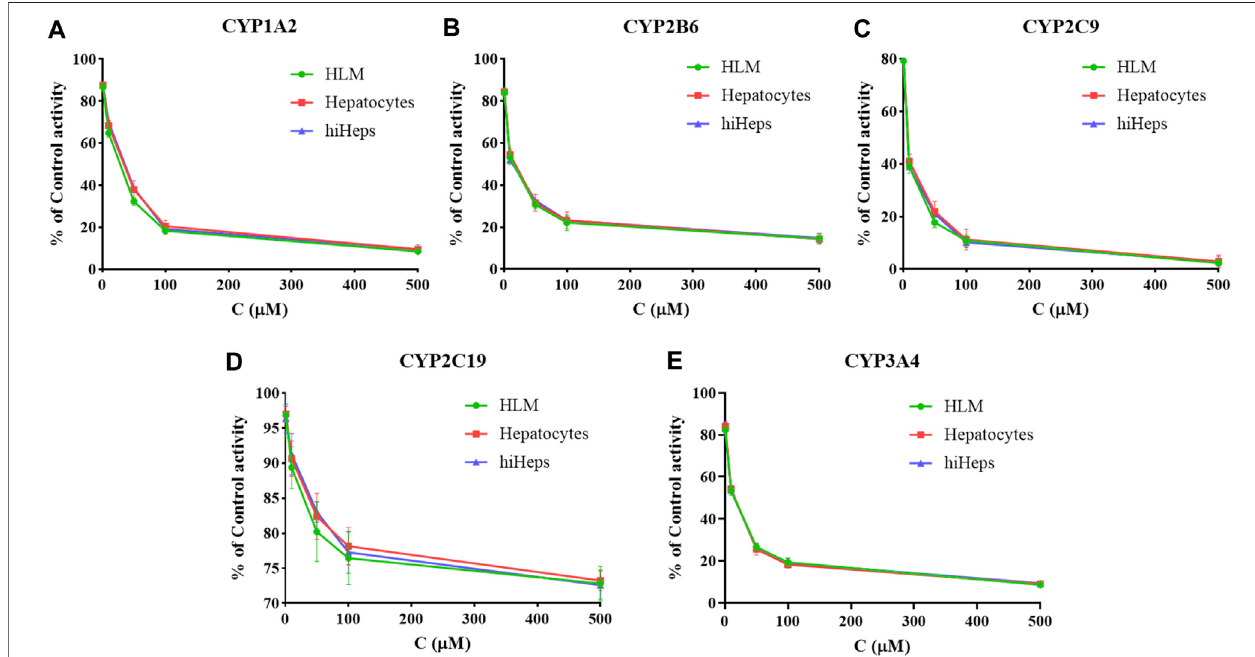
FIGURE3| TheinhibitioncurvesofcurcuminonCYP1A2 (A) ,CYP2B6 (B) ,CYP2C9 (C) ,CYP2C19 (D) ,andCYP3A4 (E) inHLM,hepatocytes,andhiHepsgroups (mean ± SD, n (cid:2) 3).